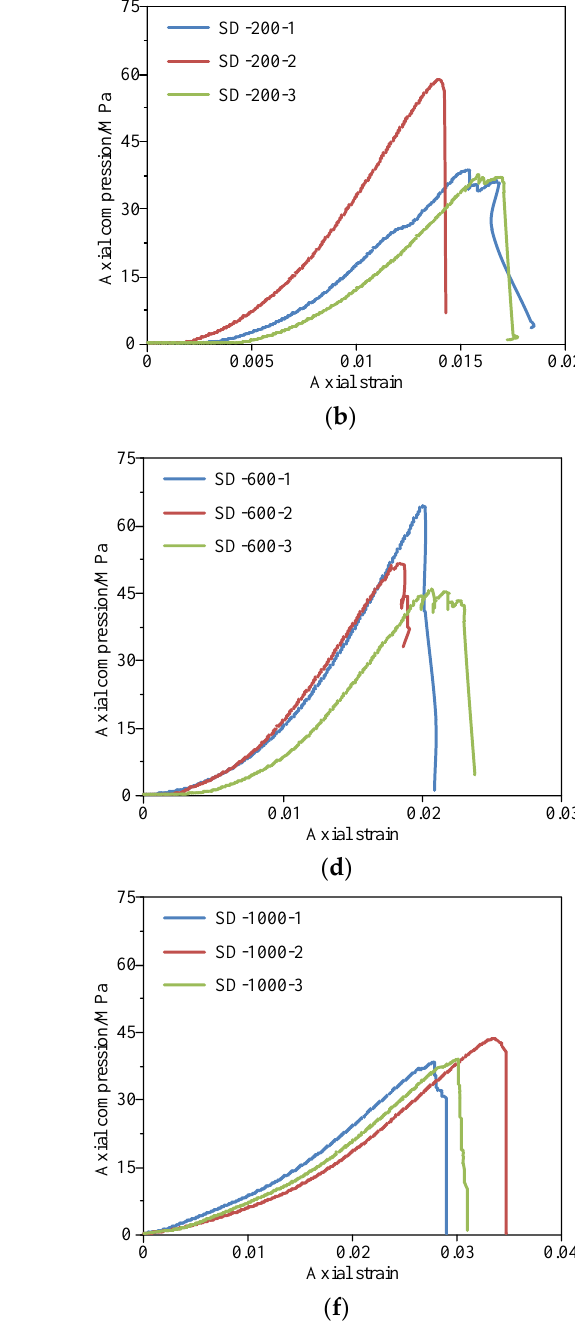
Figure 4. Complete compression stress-strain curves of sandstone under different heating temperatures. ( a ) RT; ( b ) 200 °C; ( c ) 400 °C; ( d ) 600 °C; ( e ) 800 °C; ( f ) 1000 °C. tures. ( a ) RT; ( b ) 200 ◦ C; ( c ) 400 ◦ C; ( d ) 600 ◦ C; ( e ) 800 ◦ C; ( f ) 1000 ◦